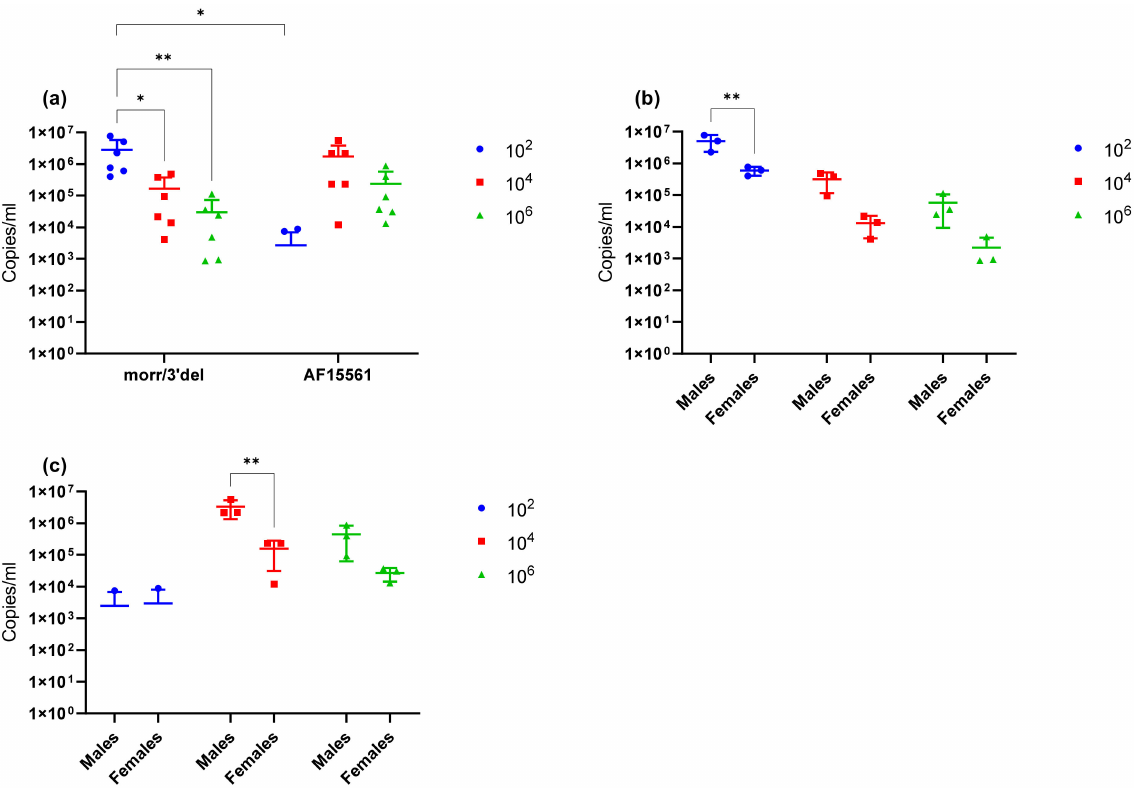
Figure 4. Serum viral loads in animals challenged with CHIKV morr/3 (cid:48) del and AF15561. Values are expressed as copies/mL of serum. ( a ) Viral RNA copy number in serum on day 3 post-infection with CHIKV morr/3 (cid:48) del and AF15561 at 1 × 10 2 , 1 × 10 4 and 1 × 10 6 dose levels. ( b ) Viral RNA copy numbers in male versus female animals challenged with CHIKV morr/3 (cid:48) del. ( c ) Viral RNA copy numbers in male versus female animals challenged with CHIKV AF15561. * p < 0.05, ** p <